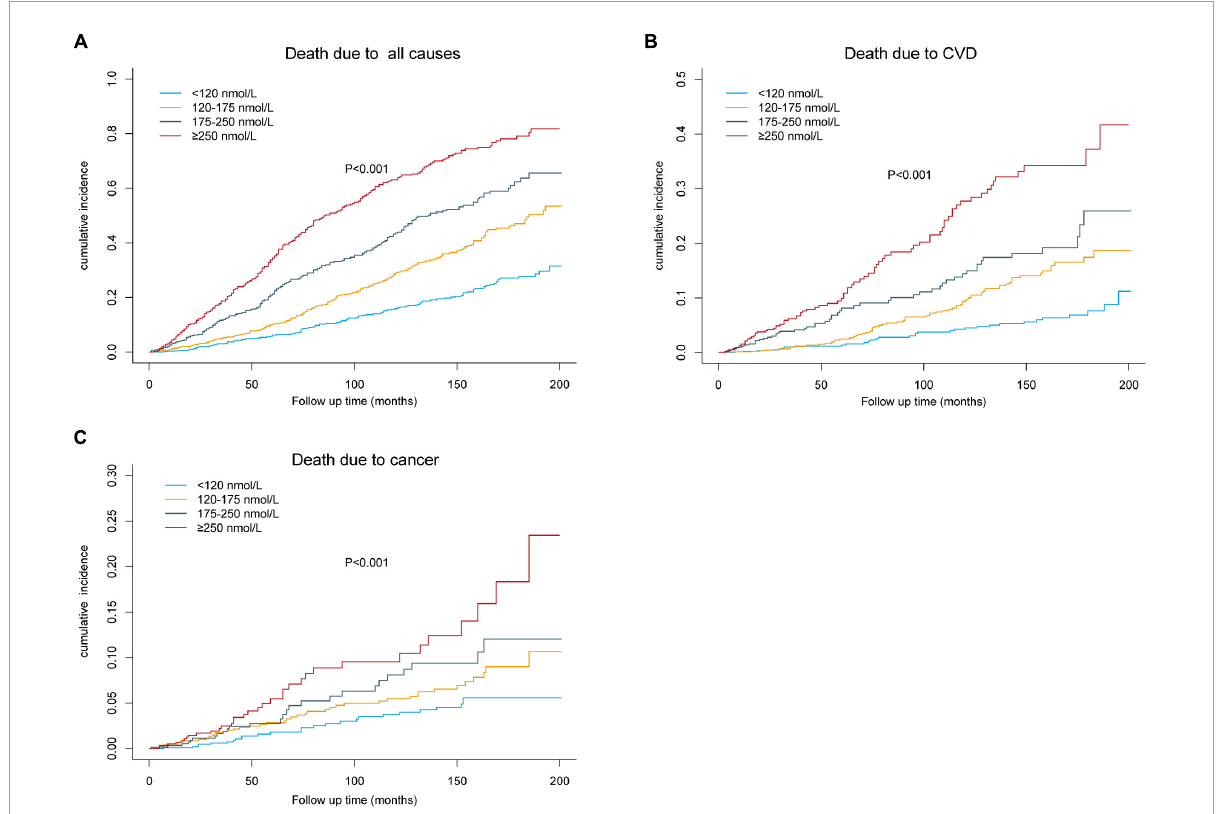
FIGURE3 Kaplan–Meier plots for all-cause and cause-specific mortality by baseline methylmalonic acid (MMA) strata. (A) All-cause mortality. (B) Cardiovascular disease (CVD) mortality. (C) Cancer mortality.